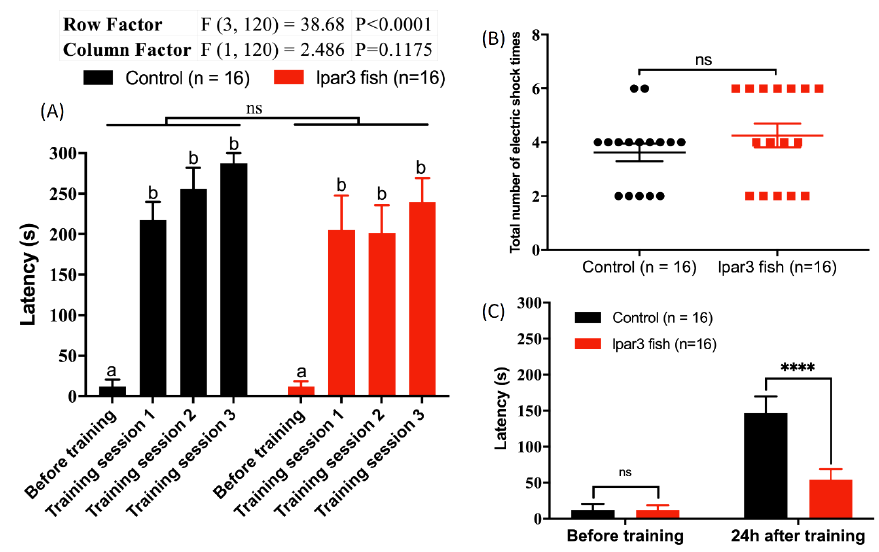
Figure 7. Comparison of the short-term memory between wild-type (WT) and lpar3 knockout zebrafish by passive avoidance test. ( A ) Comparison of the learning latency between WT (black color) and lpar3 KO fish (red color) moving into the black chamber with electric shock presence. ( B ) Comparison of the total electric shock number given for training between WT (black color) and lpar3 KO fish (red color). ( C ) Comparison of the memory latency between WT (black color) and lpar3 KO fish (red color) moving into the black chamber. Data are presented as means ± standard error of the mean (SEM) ( n = 16) and the significant difference was tested by two-way ANOVA in ( A ) and ( C ), and by t -test in ( B ) ( n = 16; ns = non-significant; **** p < 0.0001). Different letters (a, b) on the error bars represent significant differences ( p < 0.05). The fish in this test were 8 months old.